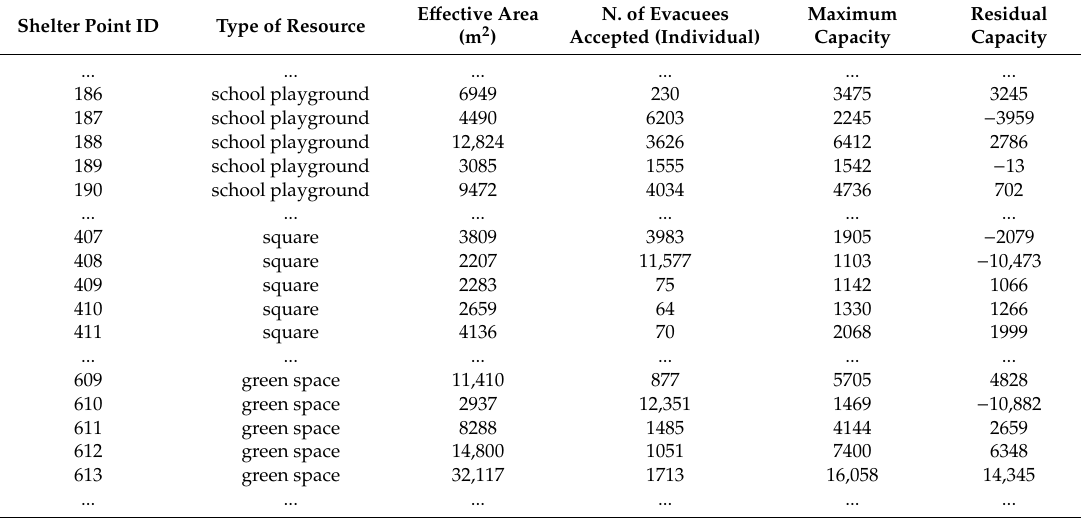
Table 6. Comparison between the number (N.) of evacuees accepted in each shelter and the capacity. E ff ective Area Shelter Point ID Type of Resource (m 2